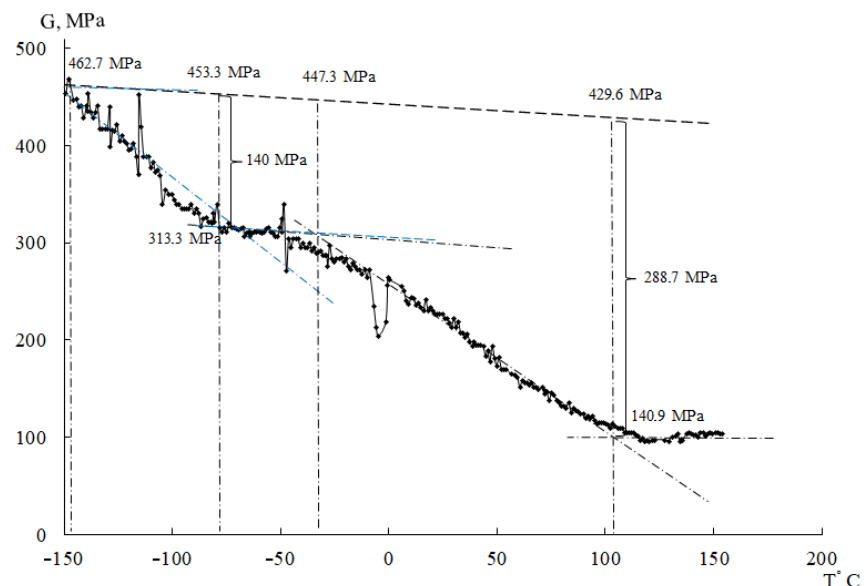
Figure 8. Temperature dependence of PE shear modulus—theoretical dependence—straight line 1 and curve 2 calculated with allowance for modulus defects for β and β k relaxation processes for CRP 100